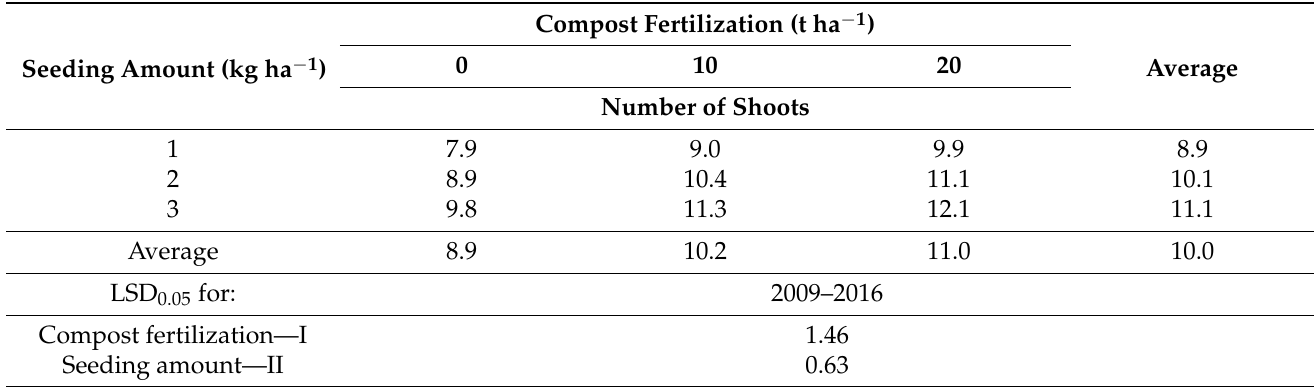
Table 4. Effects of seeding amount and fertilization with compost on the number of Sida shoots during the years of full use (2010–2016).